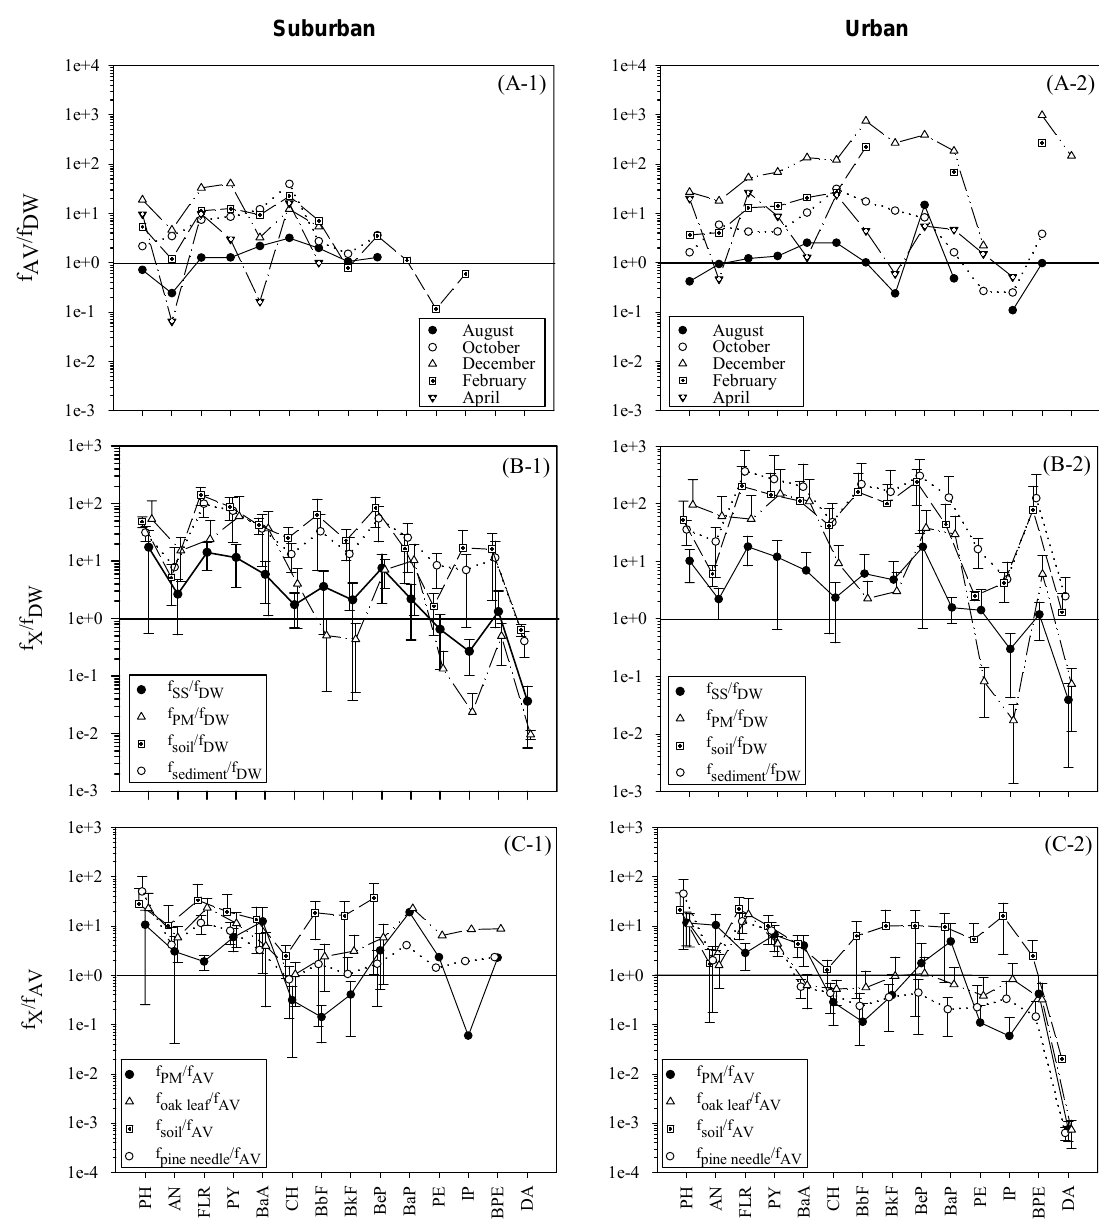
Figure 8. Comparison of the fugacity ( f ) among environmental media. Error bars denote one standard deviation of seasonal geometric means. The subscripts, AV, DW, X, SS and PM, denote vapor phase in air, dissolved phase in water, environmental solids, suspended solids in water, and PM,